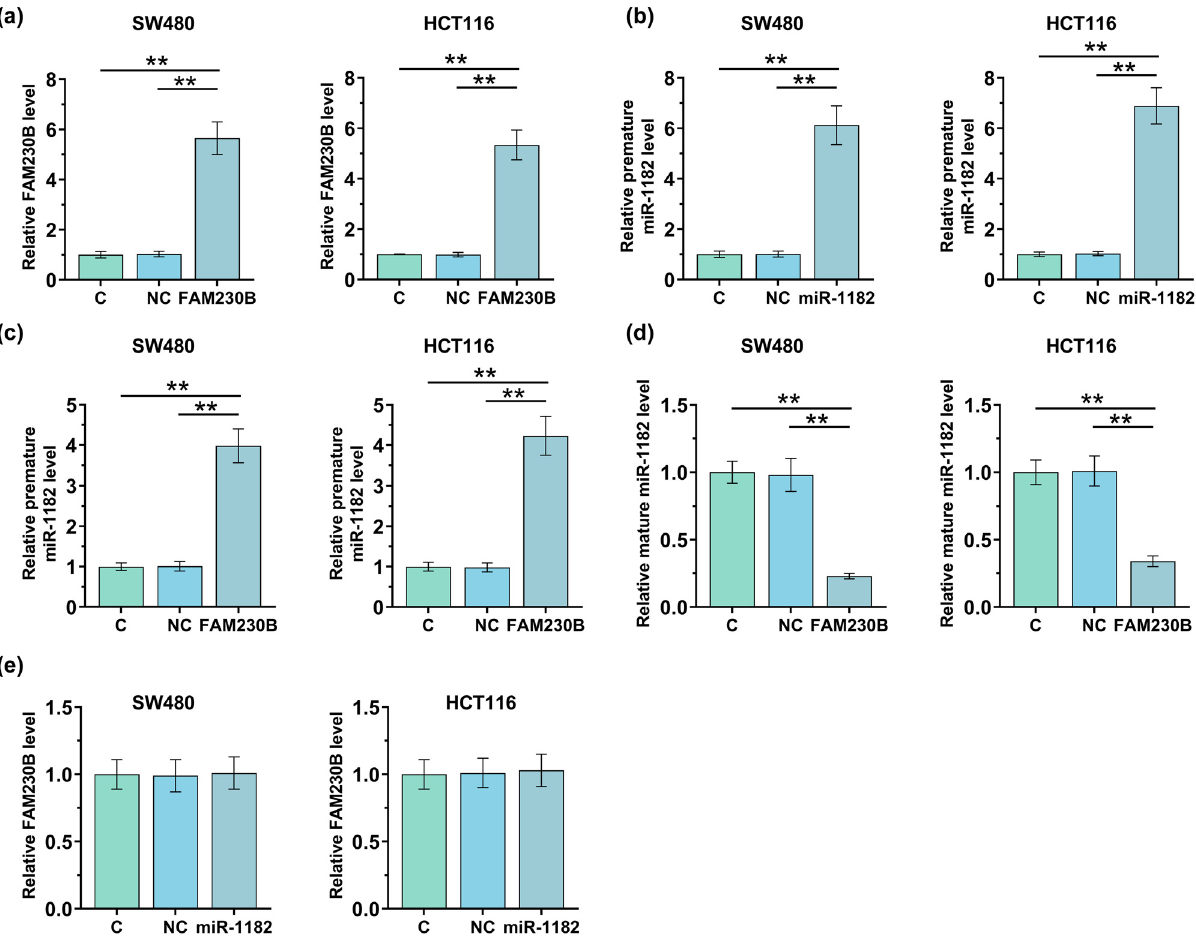
Figure 3: The involvement of FAM230B in the maturation of miR - 1182. SW480 and HCT116 cells were overexpressed with FAM230B or miR - 1182 by transfecting FAM230B expressionvector or miR - 1182 mimic. The overexpression ofFAM230B ( a ) and miR - 1182 ( b ) was con fi rmed by RT - qPCR at 48h post - transfection. The expression of premature miR - 1182 ( c ) and mature miR - 1182 ( d ) in cells with FAM230B overexpression was determined by RT - qPCR. The expression of FAM230B in cells with miR - 1182 overexpression was also analyzed with RT - qPCR ( e ) . ** p <